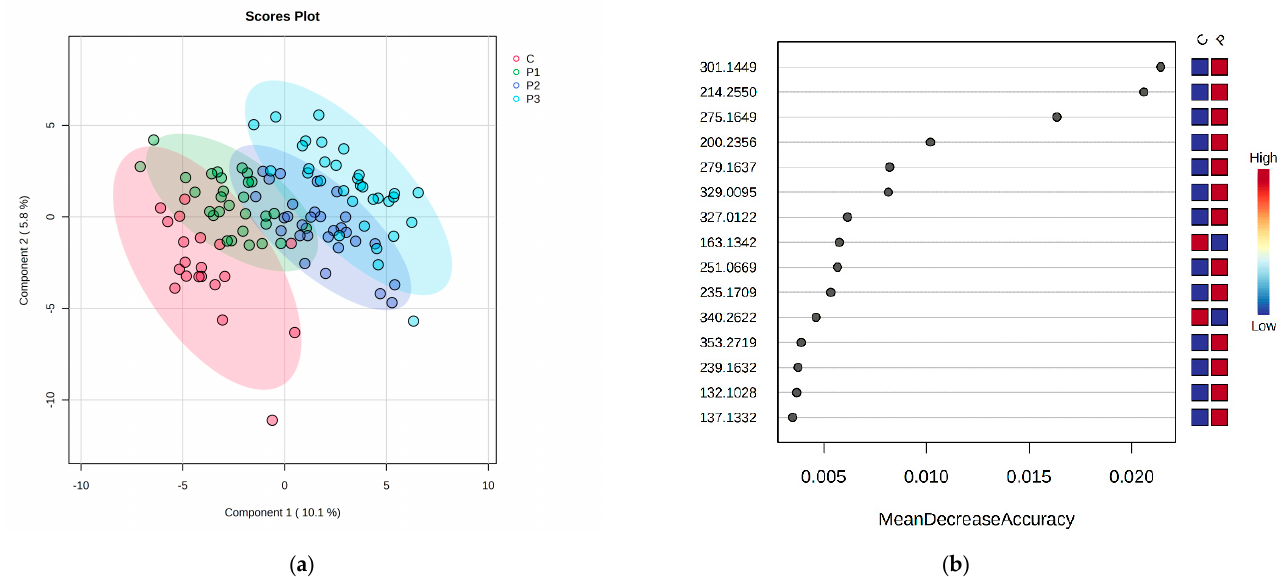
Figure 3. Univariate analysis of serum samples; ( a ) PLSDA score plot of serum samples; ( b ) Random Forest-MDA score of serum samples. Forest-MDA score of serum